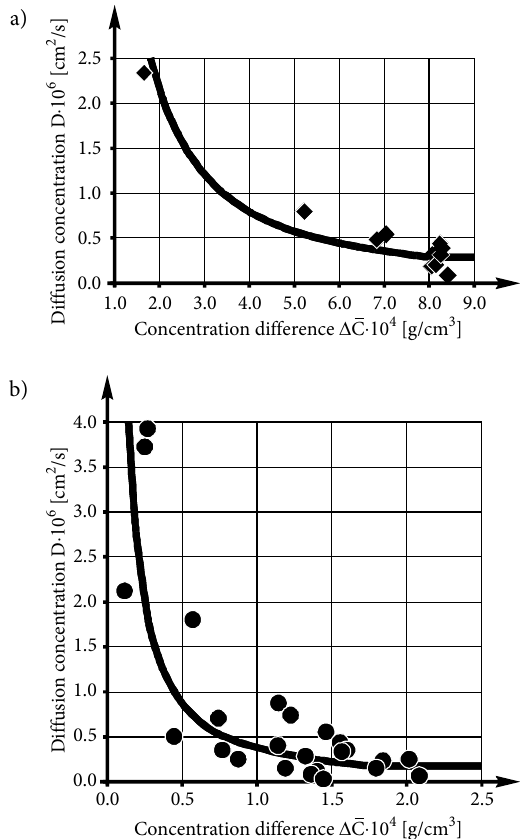
Fig. 4. The distribution of diffusion coefficient values depending on the difference in average concentrations at the edges of layers: a) compound DME, b) inhibitor